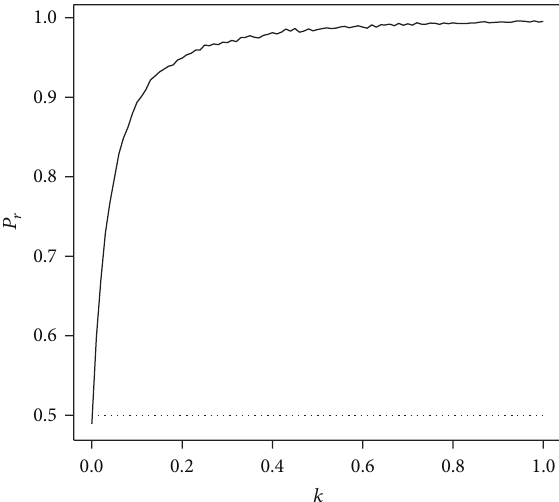
Figure 2: The PC of 𝑚𝑟 - 𝑘 class estimator relative to